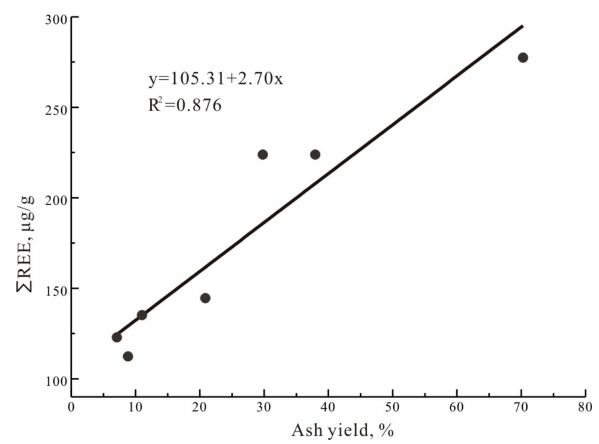
Figure 6. The relation between ash yield and ∑ REE among different density